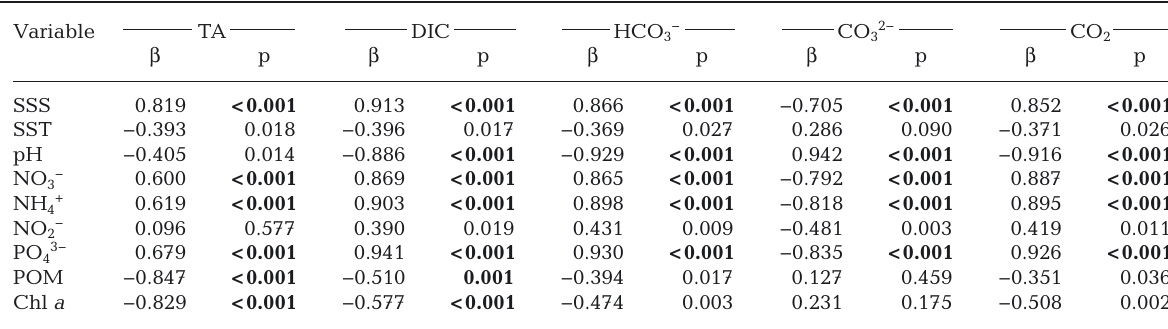
Table 1. Relationship between carbonate system parameters and hydrographic factors using the Pearson correlation test. TA: total alkalinity; DIC: dissolved inorganic carbon; HCO 3− : bicarbonate; CO 32− : carbonate; CO 2 : carbon dioxide; SSS: sea surface salinity; SST: sea surface temperature; NO 3− : nitrate; NH 4+ : ammonium; NO 2− : nitrite; PO 43− : phosphate; POM: particulate or- ganic matter. Values in bold represent significant influences, and significance was defined as the Bonferroni-corrected level of p < 0.00111 (5 carbonate system parameters × 9 hydrographic factors, at the 0.05 level). β is the Pearson correlation coeffi- cient; p is